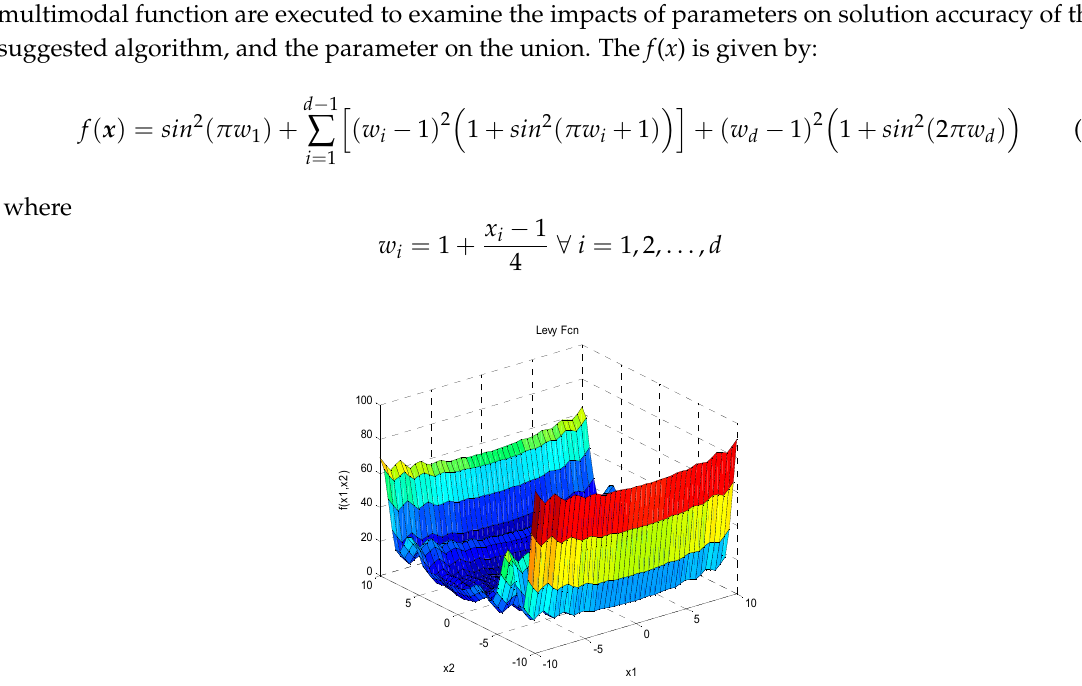
Figure 2. Levy functions in 3-D view.